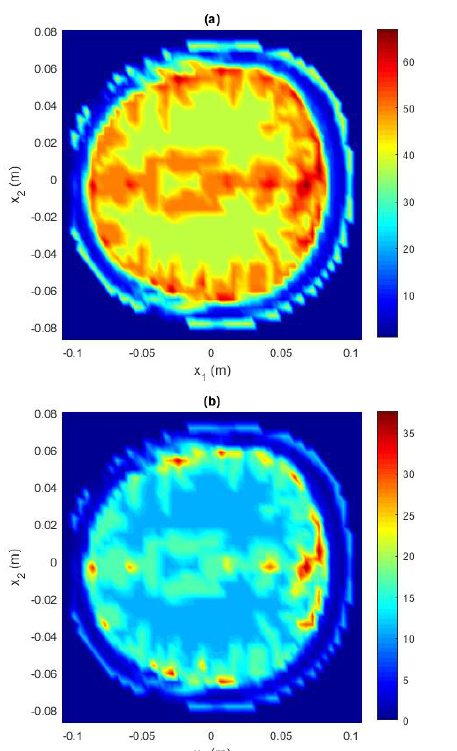
Figure 3: (a) Real parts of relative dielectric permittivity of 2-D head model with blood region, (b) Detection of blood region (Real parts of 𝛿𝑣 ) without matching medium (MM), (c) with MM 𝜀 𝑏𝑟 = 10 , (d) with MM 𝜀 𝑏𝑟 = 30